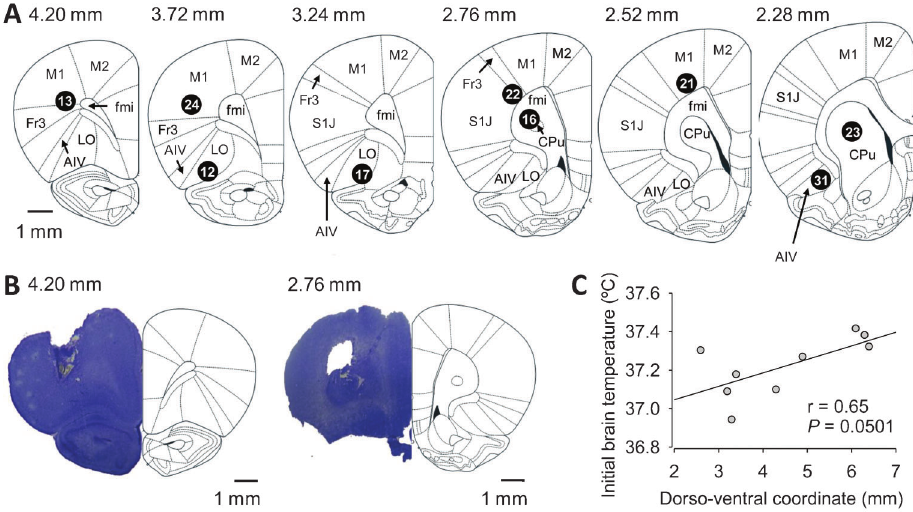
Figure 1. Coronal sections taken from the Paxinos and Watson atlas (16) showing the location of the thermistor tips ( panel A ). The numbers above the schematic of each hypothalamic section indicate the distance (in mm) between the section plane and bregma. Legends: AIV: ventral agranular insular cortex; CPu: caudate putamen; fmi: forceps minor of the corpus callosum; Fr3: area 3 of the frontal co´ rtex; LO: lateral orbital cortex; M1: primary motor cortex; M2: secondary motor cortex; S1J: primary somato- sens, jaw region; VO: ventral orbital cortex. Photomicrographs of coronal sections (50 m m, cresyl violet staining) showing the location of the thermistor tips in two rats: one rat with a thermistor inserted into the frontal cortex and another animal with a ther- mistor inserted into the caudate putamen nucleus ( panel B ). The positive correlation between the dorso-ventral location of the thermistor tip and the initial brain temperature is shown in panel C . Data are reported as individual values. Spearman correlation coefficient was used for